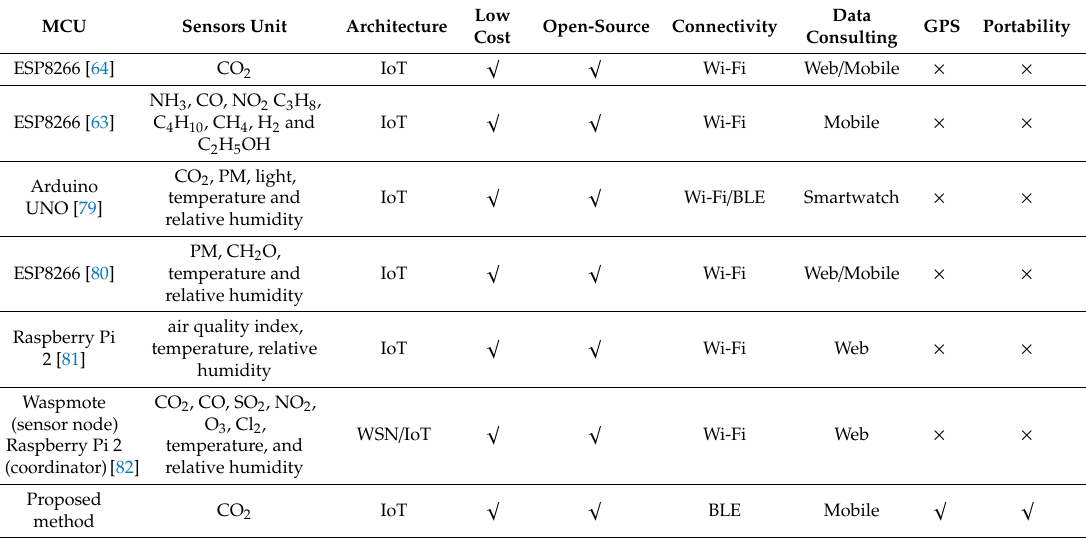
Table 4. Summarised comparison review of air quality monitoring solutions.